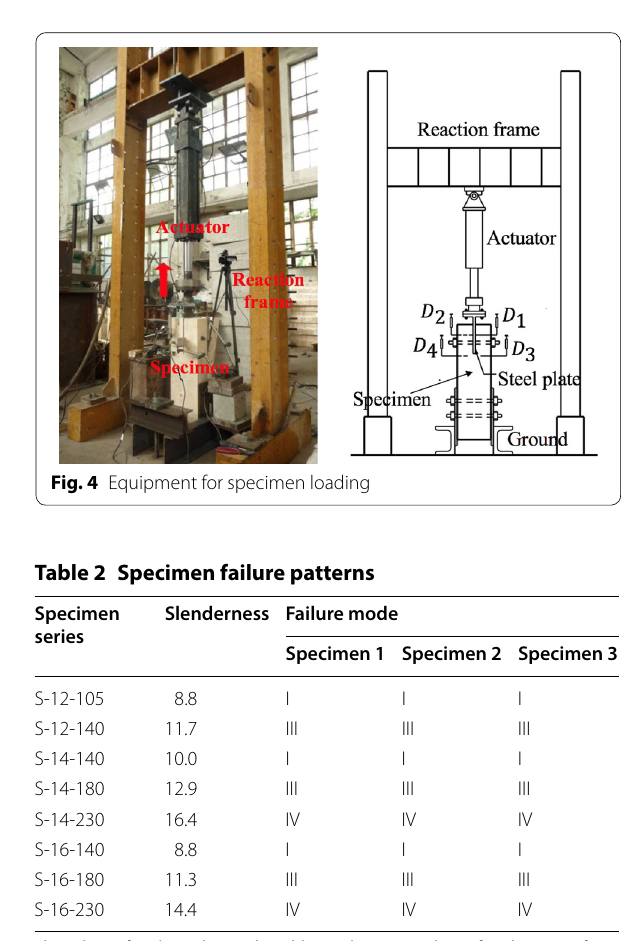
The values of P p , k e , and (cid:31) u in the table are the mean values of each group of specimens